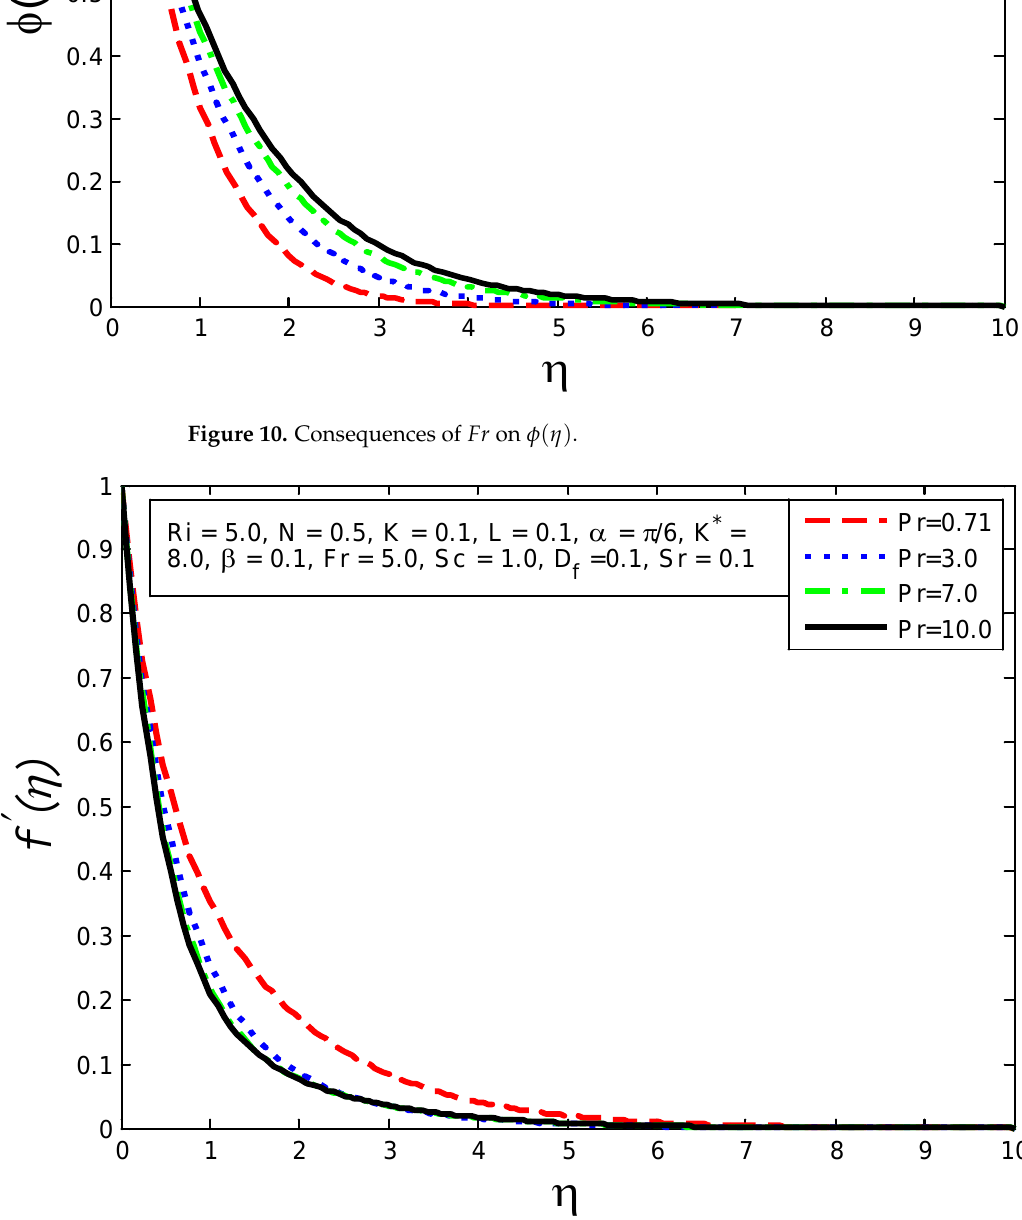
Figure 11. Consequences of Pr on f (cid:48) ( η )